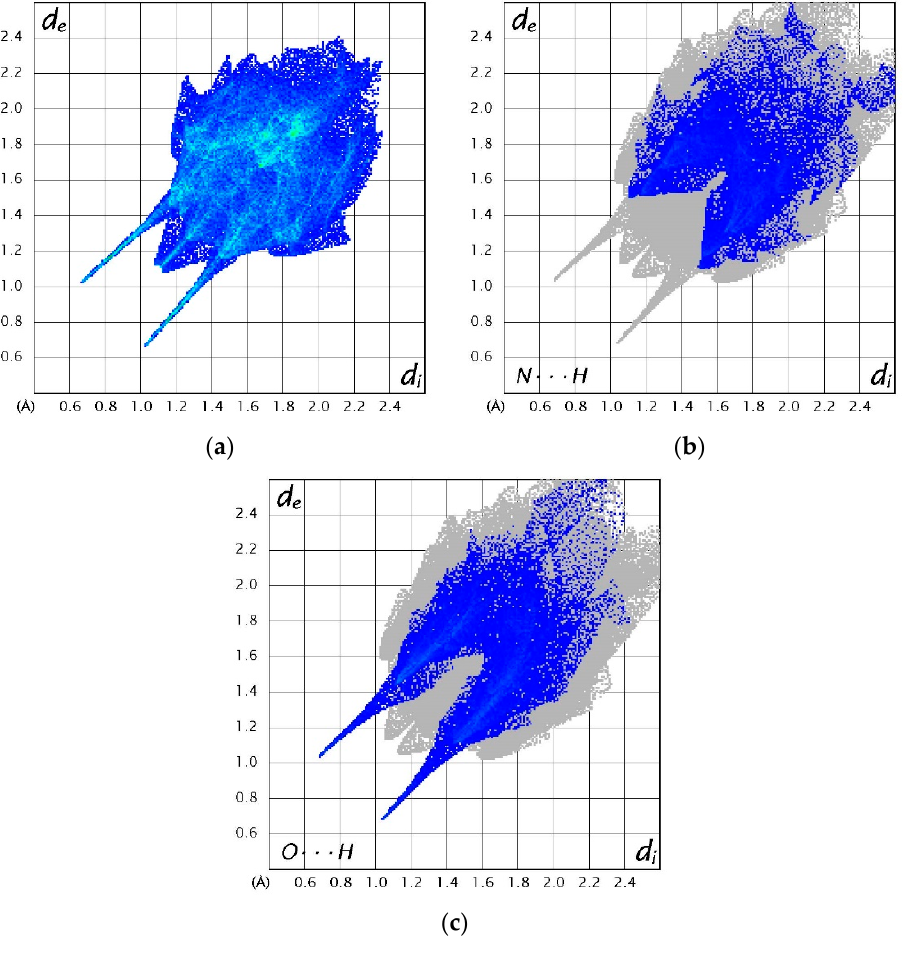
Figure 10. Two-dimensional fingerprint plots of ( a ) all interactions in ( 3 ), ( b ) N···H interactions in ( 3 ) and ( c ) O···H interactions in ( 3 ) [39].